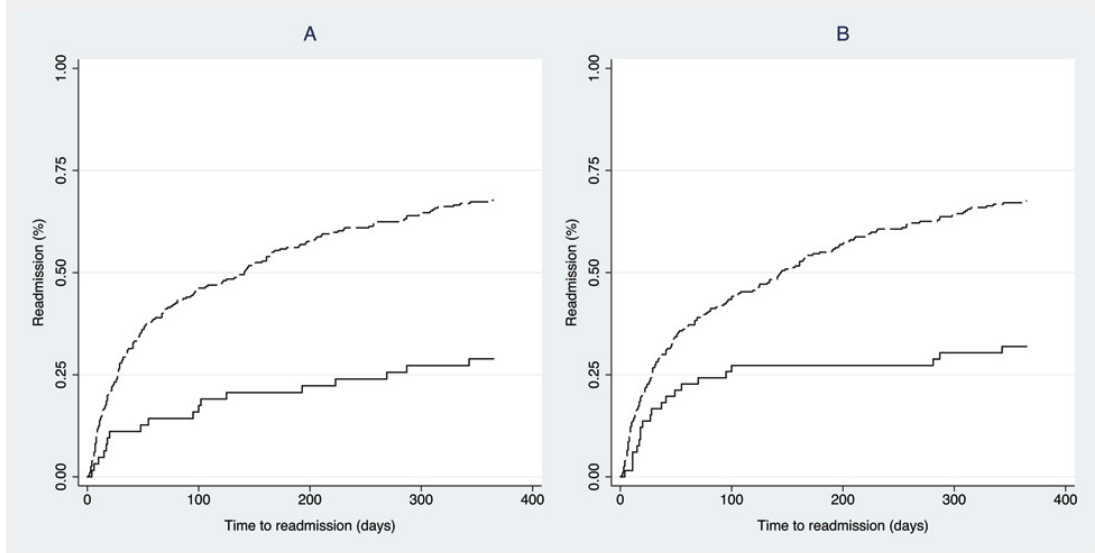
Figure 3 Kaplan-Meyer estimations curves for readmission stratified by the Identification of a Senior at Risk (ISAR) and by the Triage Risk Stratification Tool (TRST). A: ISAR <2 (plain line) - ISAR ≥2 (long-dash line), logrank test: p <0.001 B: TRST <2 (plain line) - TRST ≥2 (long-dash line), logrank test: p